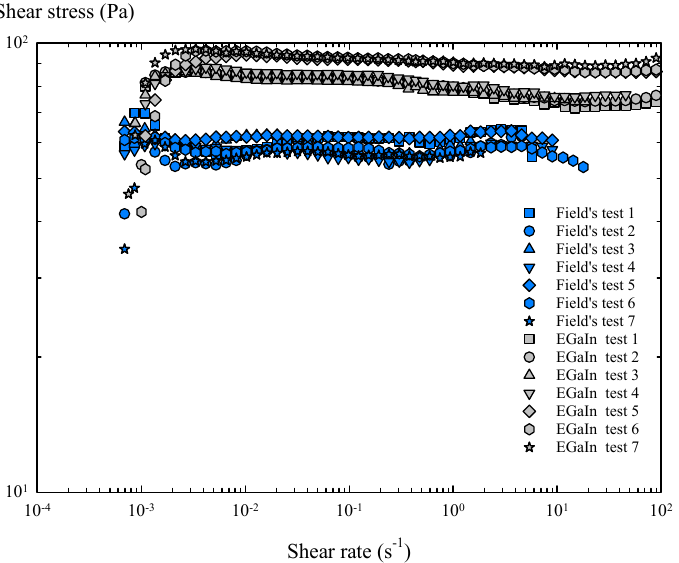
Figure 8. Viscosity curves of oxidized Field’s metal and EGaIn obtained in steady torsional flow tests. For the rotational tests with torsional flow ramp (Figures 9 and 10), the results were very similar to those obtained with a steady torsional flow, and the oxide skin also main- tained the shear stress value after a certain critical shear rate was exceeded during the flow ramp. However, the yield stress values achieved in each flow test vary slightly (Figures 7 and 9), which can mainly be attributed to the differences between samples due to their manual loading in the rheometer.